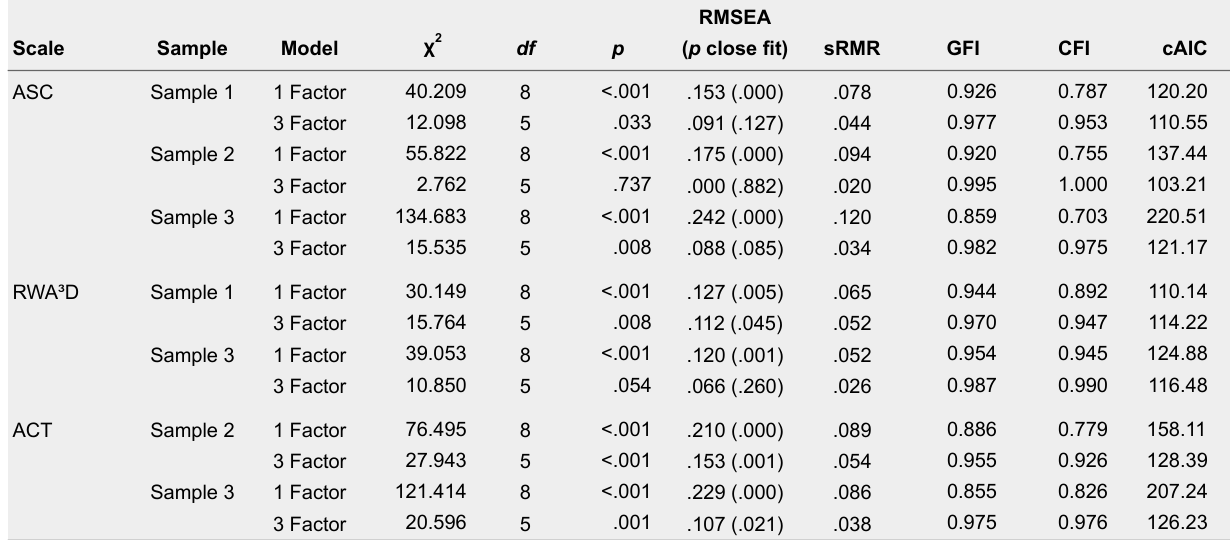
Confirmatory Factor Analysis Model Fit (Comparing 1 Factor vs 3 Factor Models, Both With Orthogonal Method